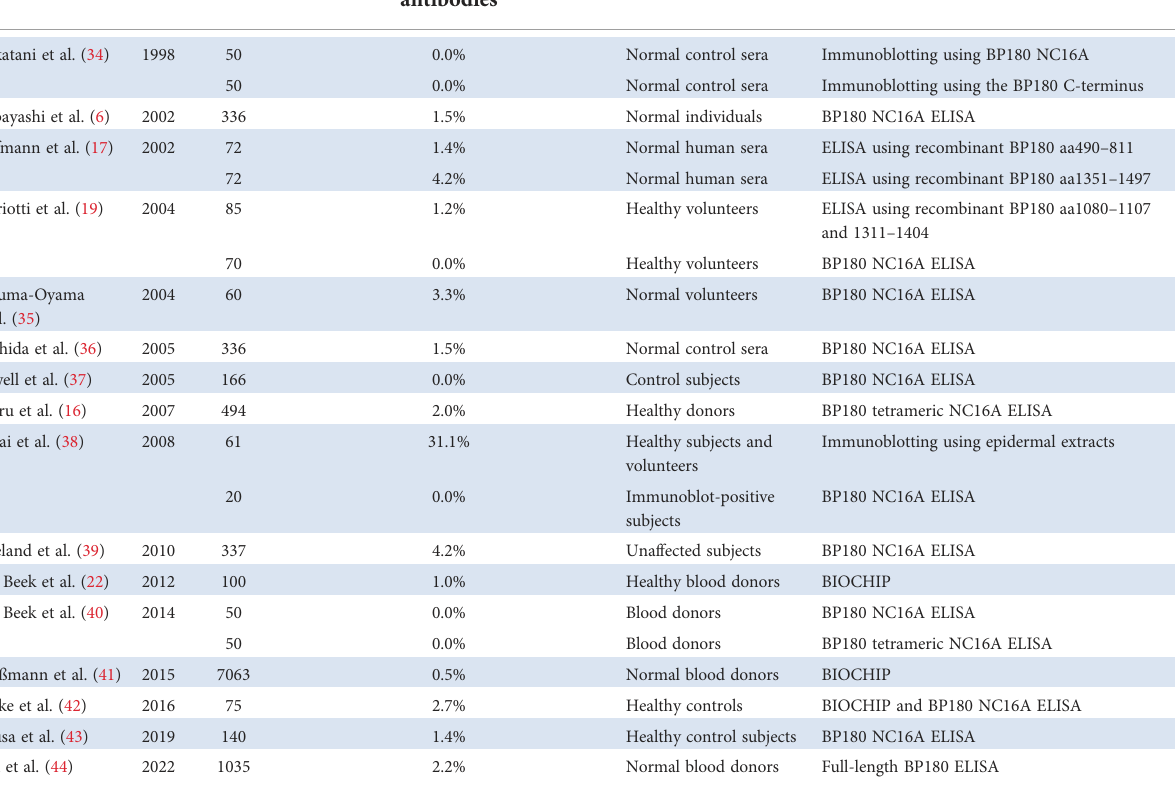
TABLE 1 The prevalences of anti-BP180 autoantibodies in normal healthy